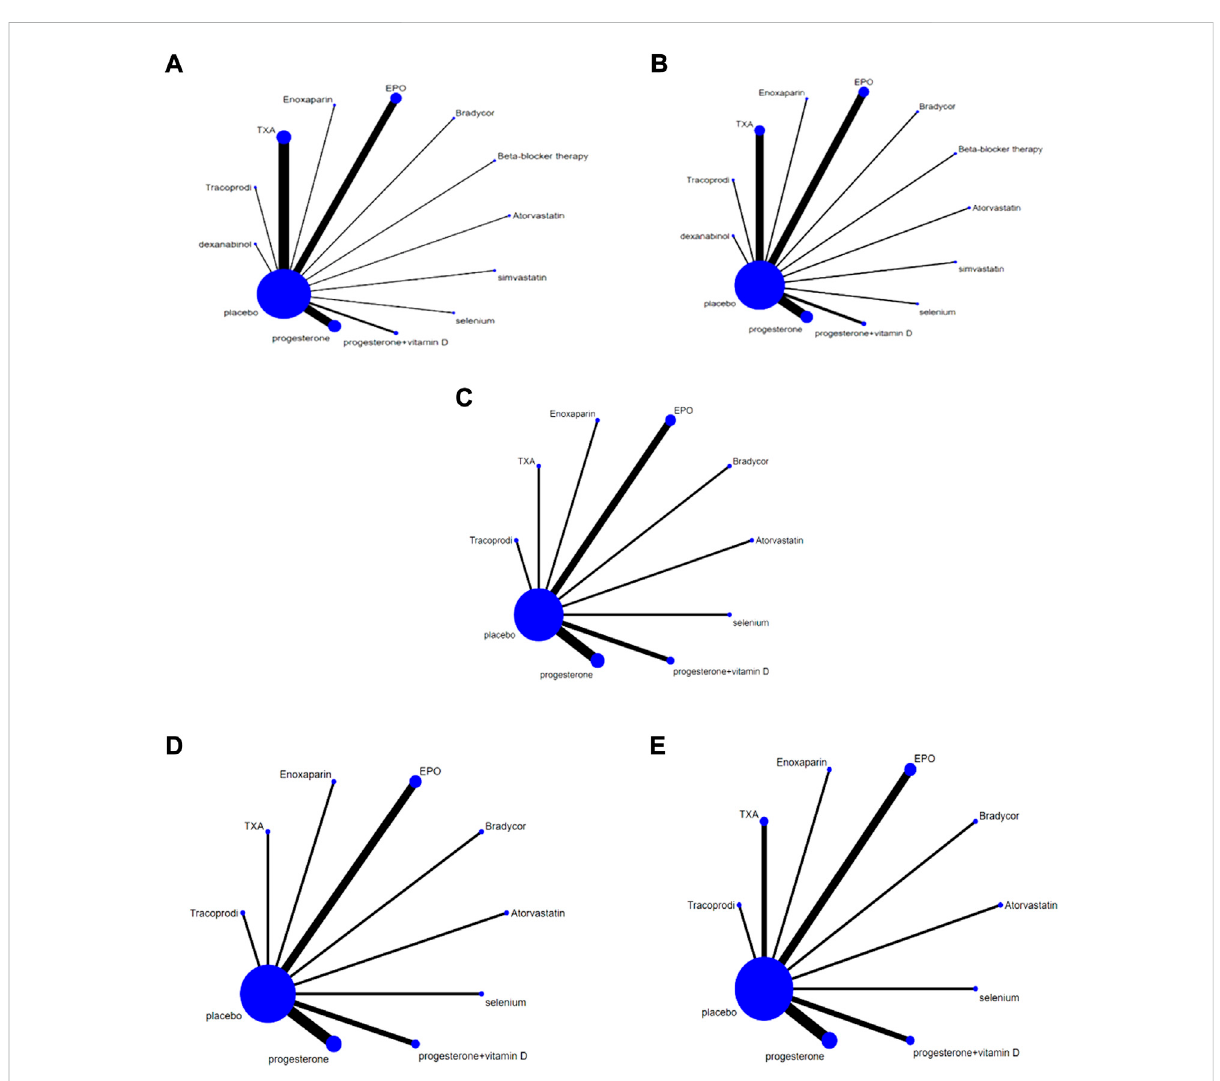
FIGURE 4 Network Chart; (A) Network chart based on the mortality of TBI; (B) . Network chart based on the patient proportion of the favorable result of TBI; (C) . Network chart based on the patient proportion of the good recovery of TBI; (D) . Network chart based on the patient proportion of the moderate disability of TBI; (E) . Network chart based on the patient proportion of the severe disability of